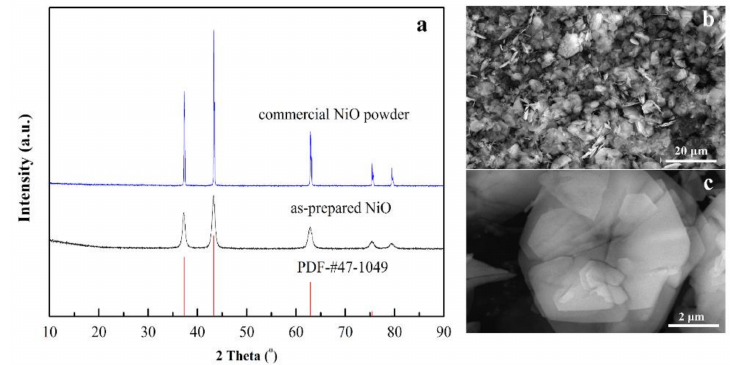
Figure 1. X-ray diffractometer (XRD) pattern ( a ) and the Scanning Electron Microscope (SEM) images ( b ) and ( c ) of the as-synthesized